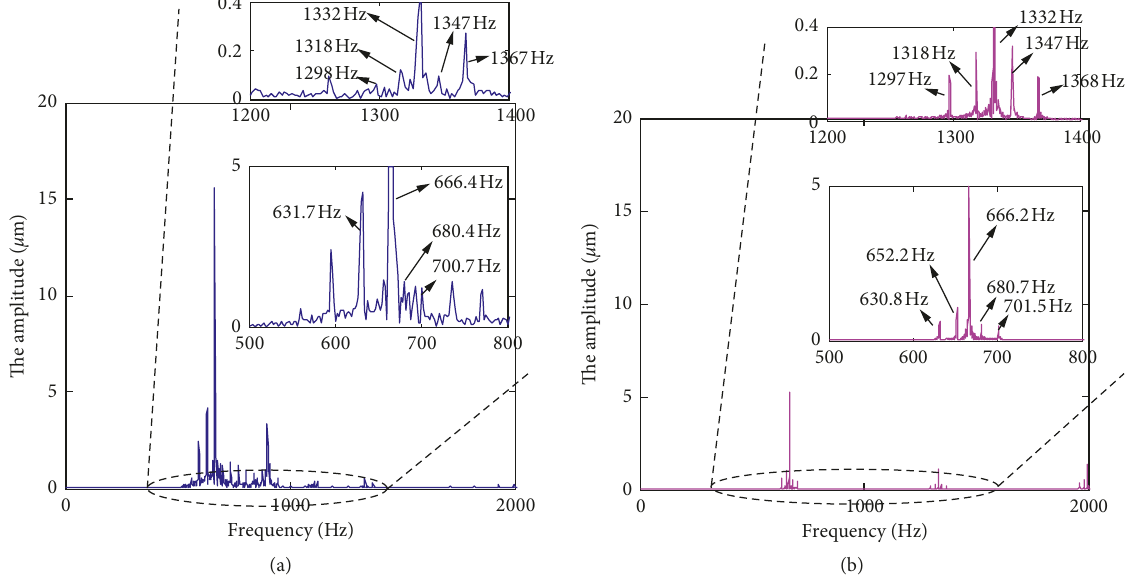
Figure 25: Spectrum and partial enlarged view of gear frequency component of dynamic transmission error: (a) experiment; (b) simulation by using the proposed